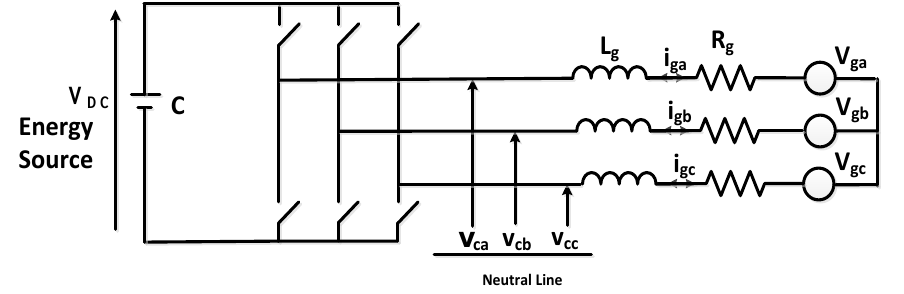
Figure 1. Equivalent circuit of the GCI in the abc frame.